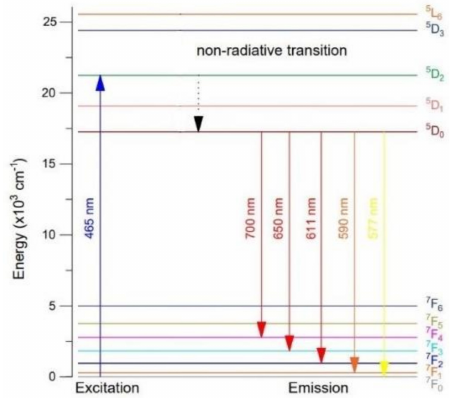
Figure 12. Energy level diagram of Eu 3+ ions in the investigated glasses. The fluorescence intensity ratio (R) for the Eu 3+ -doped glasses with various TeO 2 /GeO 2 molar ratios are shown in Figure 13. The high fluorescence intensity ratio (R) values in- dicated that europium ions occupy the low symmetry sites [63,75,76]. Hence, the high R values indicated the covalent nature of the Eu-O bond [77,78]. It was also observed that the asymmetry was decreased with an increase in GeO 2 content up to 15 mol%. However, the addition of germanium dioxide above 15 mol% increased the asymmetry of Eu 3+ ions.